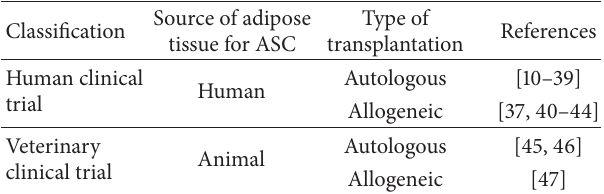
Table 1: Papers included in this survey that reported on the use of ASC for human and veterinary clinical